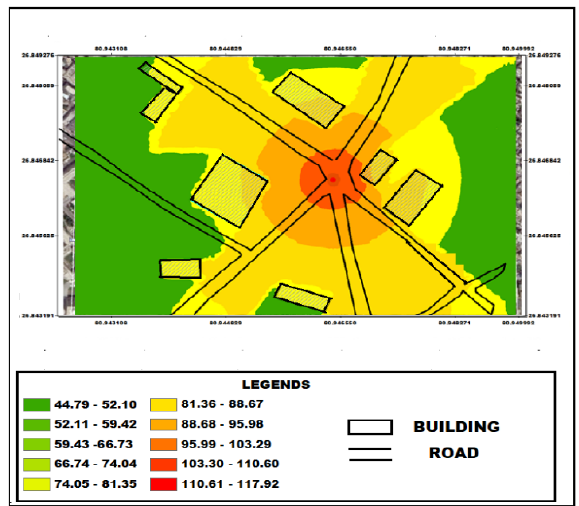
Figure 11. 2D Noise level map of Hazartganj Intersection (noise level lies in between 44.79 to 117.92 dB(A)) from single point source and it’s the instantaneous noise that has been monitored and mapped.